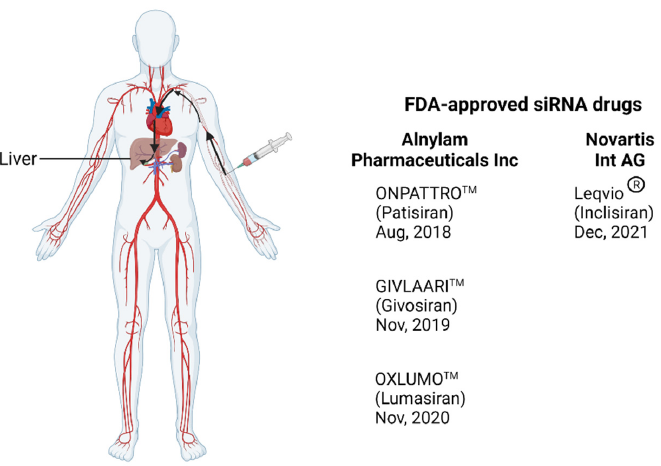
Figure 1. Illustration of the delivery route of FDA-approved siRNA from injection to the liver through the circulation system. The drug enters the circulatory system after it is administered intravenously and reaches the liver where it targets hepatocytes. Created with BioRender.com. Viral infections, such as HIV infection, occur in various sites other than the liver.